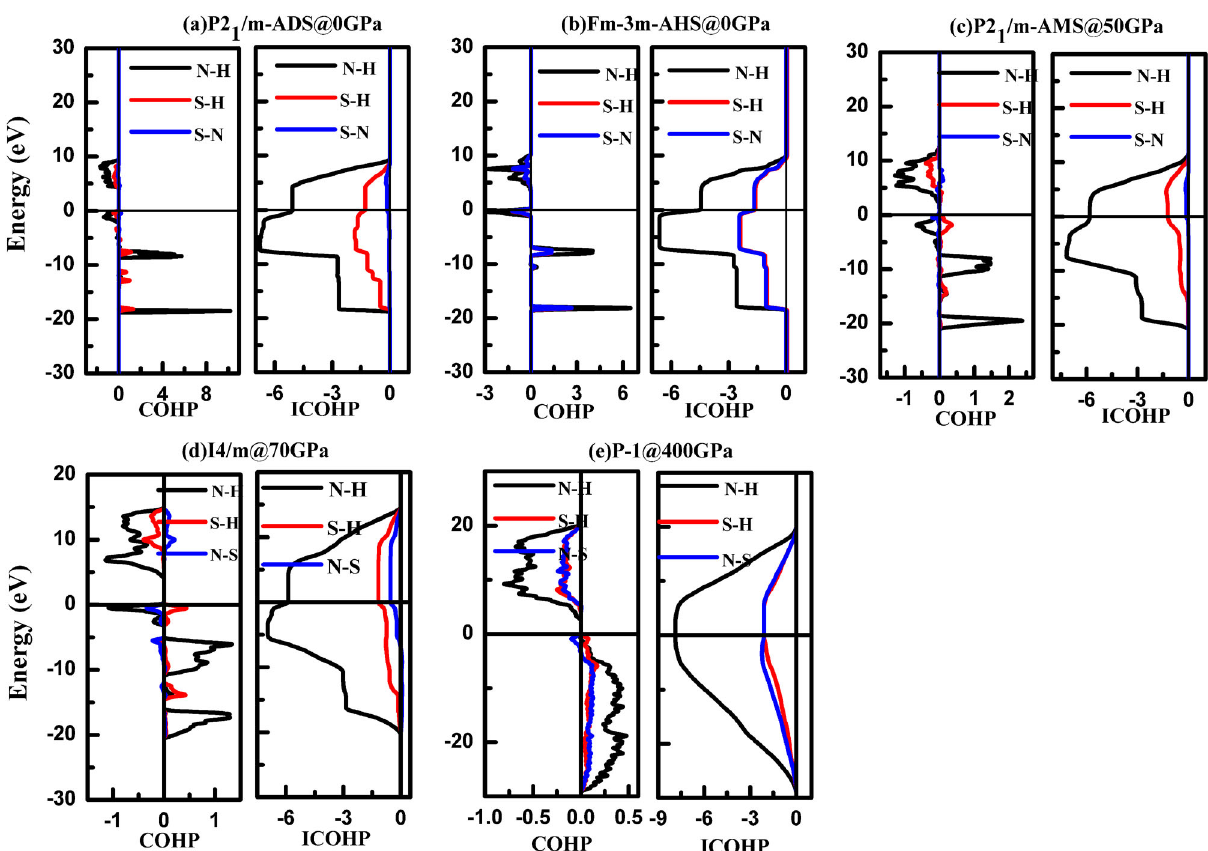
Fig. 5 Crystal overlap Hamilton population analyses of different mixtures under pressure. The COHP and integrated COHP (ICOHP) as function of energy shown for a P2 1 /m -ADS at 0 GPa, b Fm-3m -AHS at 0 GPa, c P2 1 /m -AMS at 50 GPa, d I4/m -AQS at 70 GPa, e P-1 -AQS at 400 GPa.